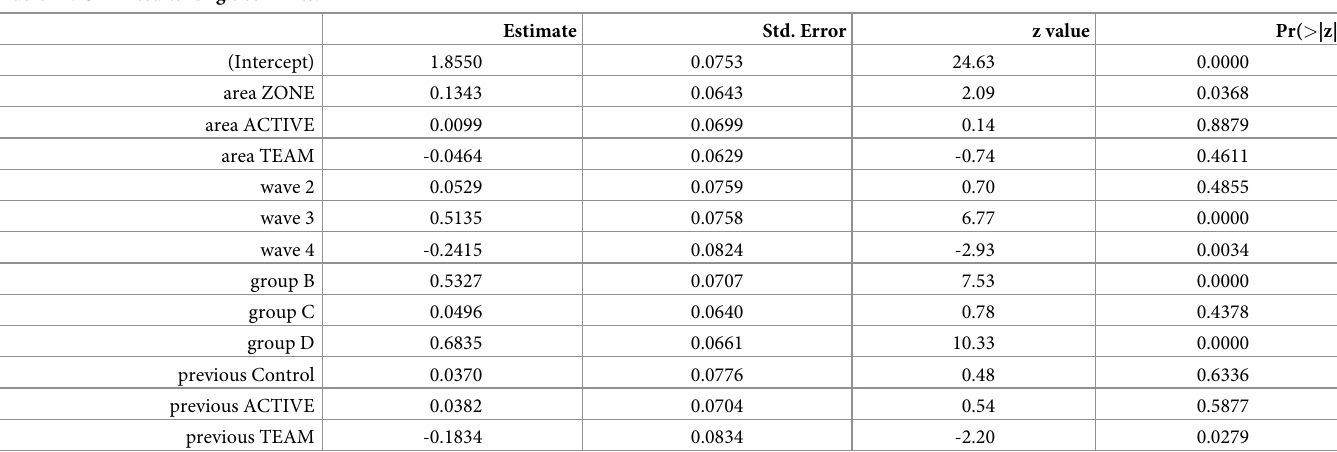
Table 22. GLM results for git commits.